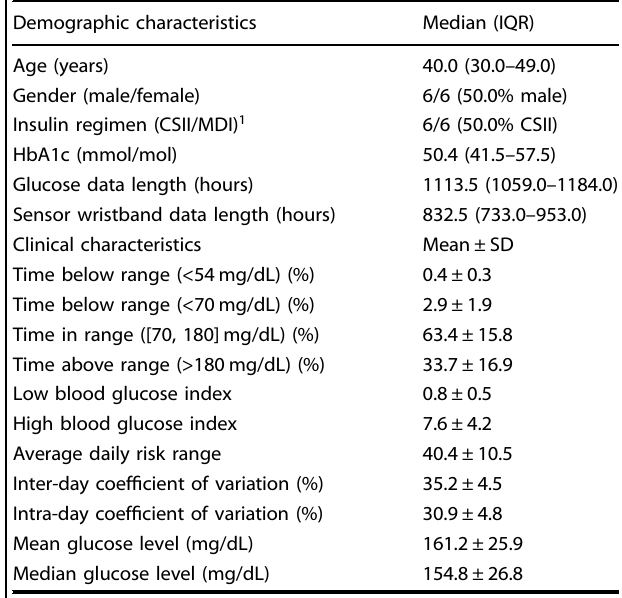
Table 1. Demographic characteristics and clinical characteristics of the 12 T1D participants in the phase I clinical